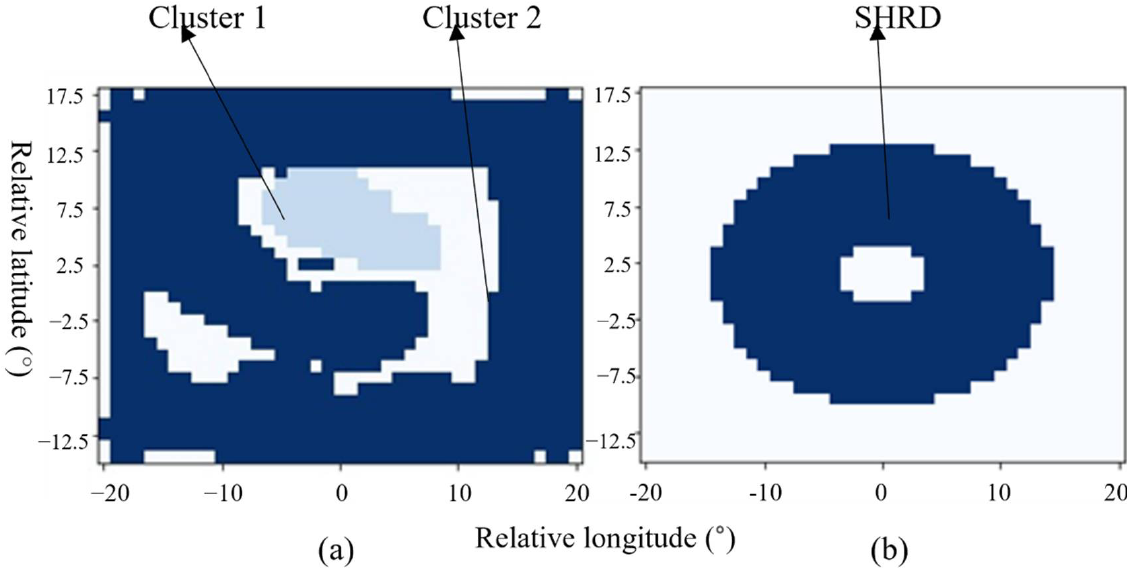
Figure 10. ( a ) Two SNN clusters of 850–200 hPa vertical shear that are significantly different in RI and non-RI groups, and ( b ) SHRD in SHIPS database.